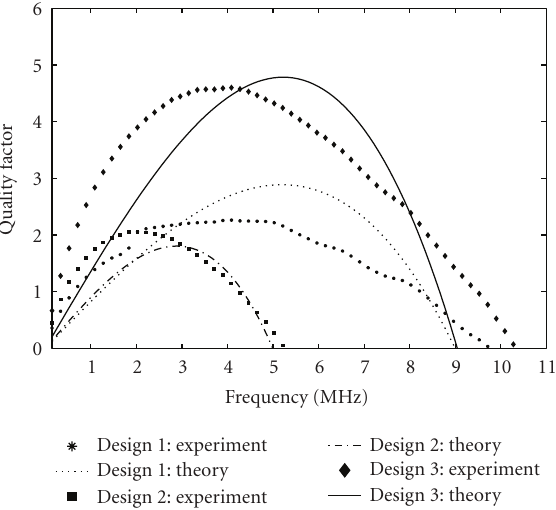
Figure 8: MLSI designs with variable